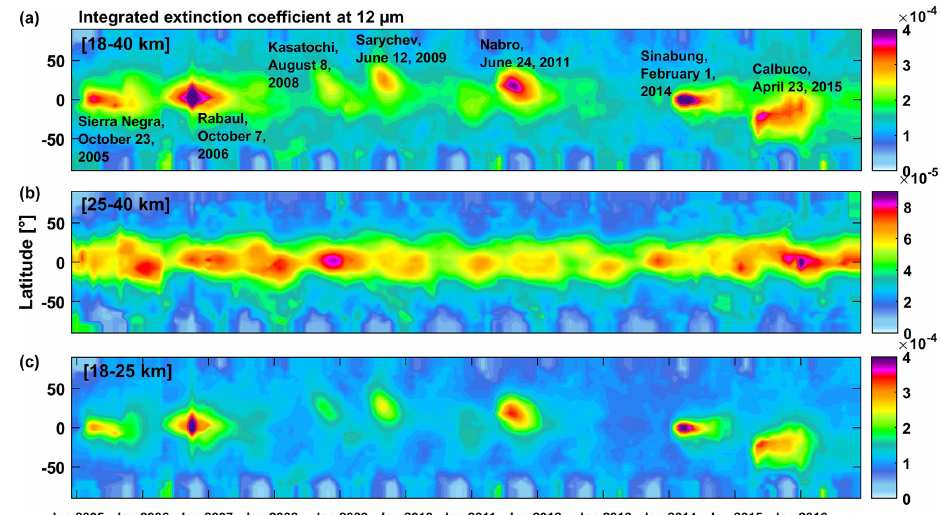
Figure 3. Latitudinal distribution of volcanic sulfuric acid extinction coefficient at 12µm integrated (a) over the stratosphere, (b) over the middle stratosphere and (c) over the lower stratosphere, as a function of time from 2005 to 2017. The dataset consists of monthly mean aerosol data merged from SAGE, SAM, CALIPSO, OSIRIS, 2-D model simulation and Photometer (processed at NASA Langley Research Center, USA, and ETH Zurich,